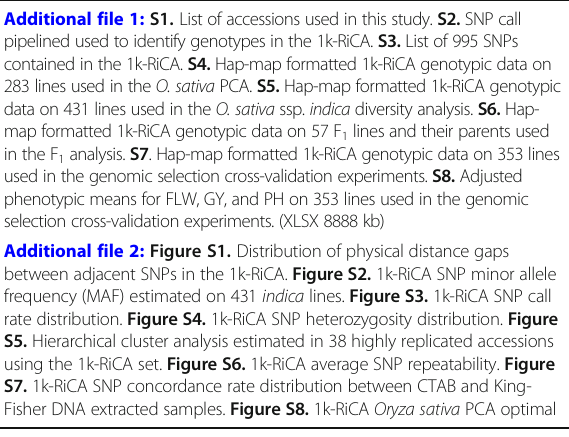
clustering and Silhouette width test. Figure S9. 1k-RiCA Oryza sativa PCA classification. Figure S10. 1k-RiCA distribution of F 1 percentage of similarity between true F 1 and predicted F 1 . Figure S11. Phenotypic distribution for flowering time (FLW), grain yield (GY), and plant height (PH). Table S1. Cross-reference identification for 12 ‘ undermined ’ rice accessions classified using PC coordinates. Table S2. Grouping analysis using PC coordinates between indica lines. (DOCX 925